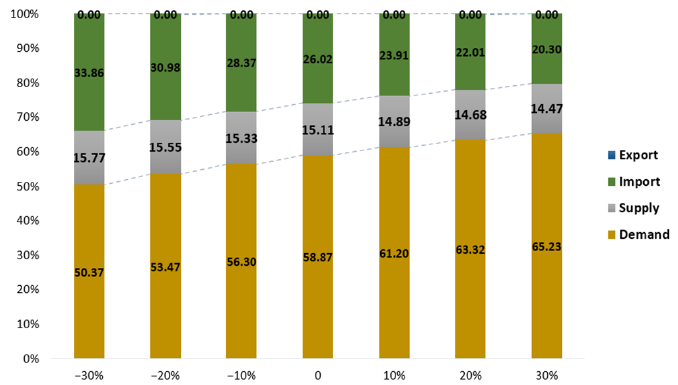
Figure 5. Numerical simulation results of dried red pepper.